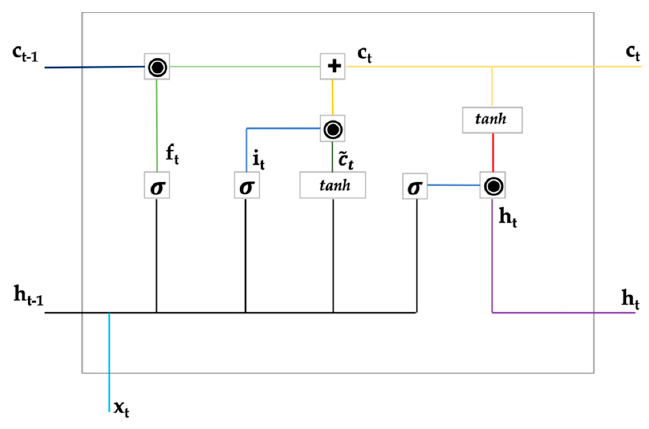
Figure 1. Architecture of a long short-term memory (LSTM) cell. + : “plus” operation; ◉ : “Hadamard